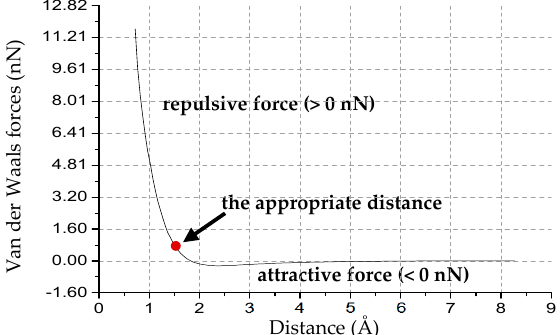
Figure 2. Van der Waals force–distance curve of the nanoindentation on SLMoS 2 . The repulsive force is given by larger than 0 nN, and the attractive force is smaller than 0 nN. The red point is the chosen reference point, which corresponds to the appropriate distance (1.47 Å) between the lowermost atoms of the tip and the uppermost layer of S atoms of SLMoS 2 .